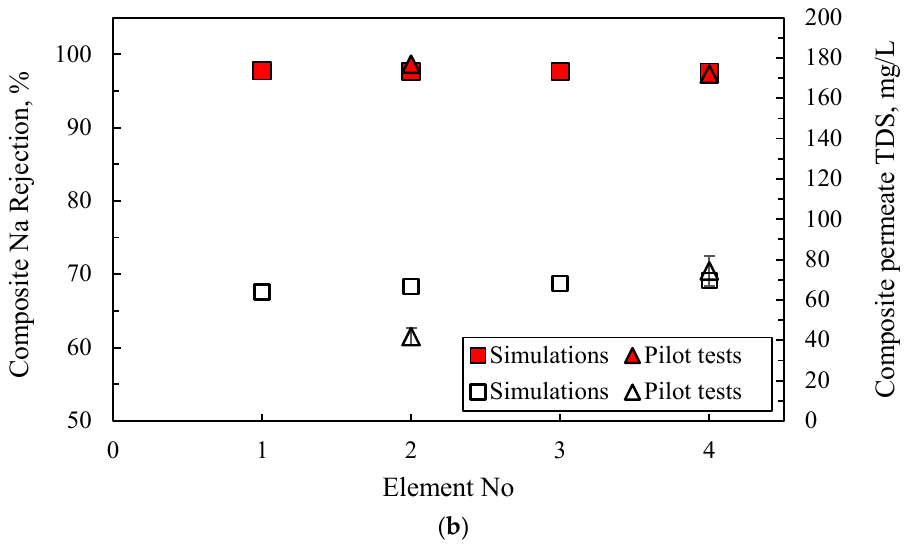
Figure 11. Axial variation (along 4 SWM modules in series) of NF membrane process parameters. Comparison of pilot test data with simulation results at the exit of each SWM module. ( a ) Permeate % recovery and ( b ) permeate TDS concentration and Na rejection.